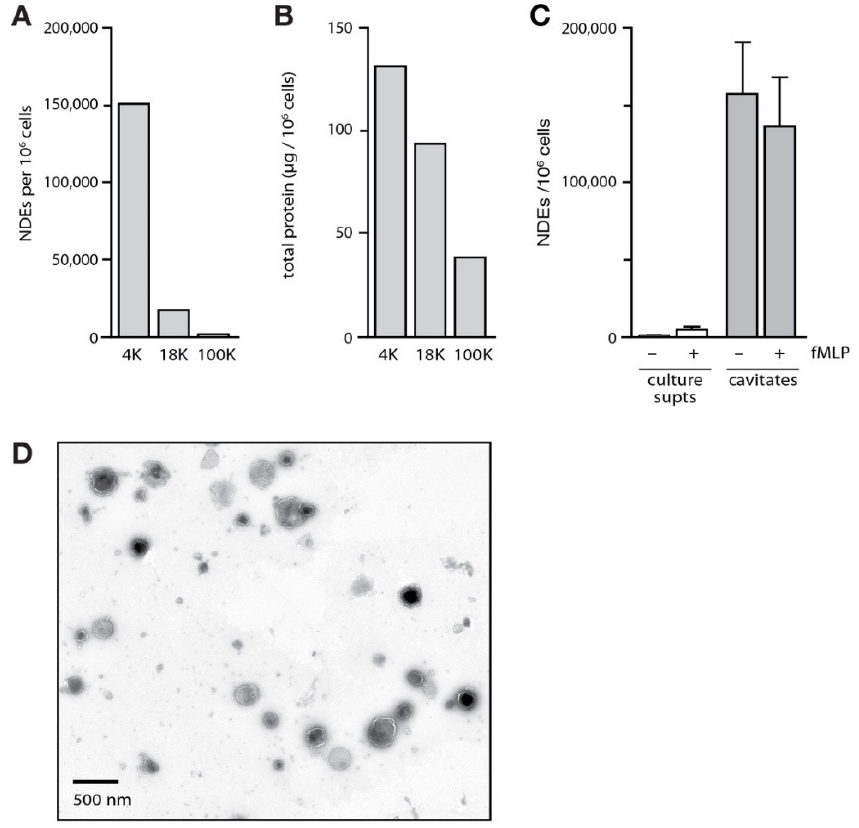
Figure 4. Isolation and properties of NDEs released by cavitated neutrophils. ( A ) Cavitates from neutrophils stimulated for 60 min with 100 nM fMLP were centrifuged at 1000× g ; the resulting supernatants were centrifuged at 4000× g and the pellets (“4K”) were processed for flow cytometry analysis of NDEs as described in Methods . The post 4000 supernatants were centrifuged at 18,000× g and the pellets (“18K”) were processed for flow cytometry analysis of MNDEs, while the 18,000 supernatants were further centrifuged at 100,000× g (2 h, 4°C) and the resulting pellets (“100K”) were processed for flow cytometry analysis of NDEs. The experiment depicted is representative of three. ( B ) Samples depicted in panel A were also analyzed for total protein determination in Brad- ford assays. ( C ) Neutrophils were cultured in the absence or presence of 100 nM fMLP for 60 min and NDEs were isolated from either culture supernatants or cavitates, and processed for flow cy- tometry analysis of NDEs as described in Methods. Mean ± s.e.m. from 3 independent experiments. ( D ) Transmission electron micrograph of isolated NDEs from the 4000× g pellets of cavitates from fMLP-stimulated cells. The micrograph is representative of three independent experiments.